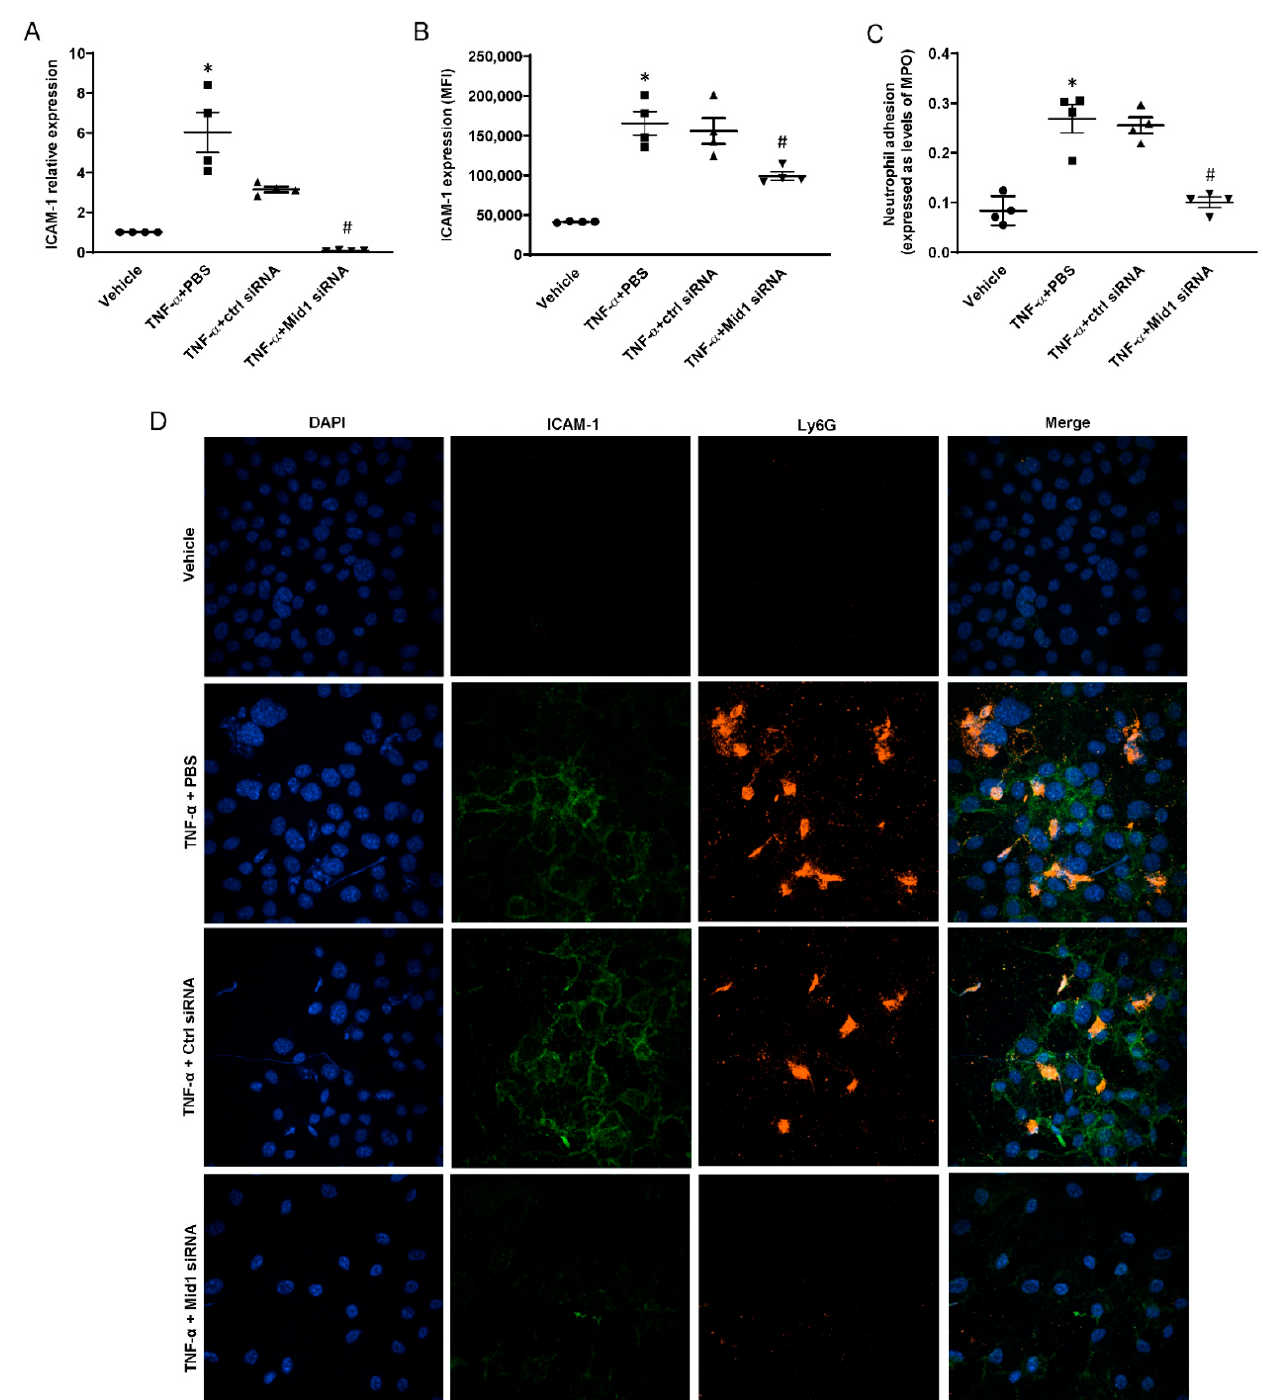
Figure 2. Mid1 siRNA reduced the expression of ICAM-1 and neutrophil adhesion in vitro. eEnd.2 cells were transfected with 100 nM negative control siRNA and Mid1 siRNA for 24 h, then stimulated with 100 ng/mL TNF- α . ( A ) ICAM-1 mRNA expression was determined by RT-qPCR 1 h after stimulation. ( B ) ICAM-1 surface expression was determined by flow cytometry 3 h after stimulation. For the assay of neutrophil adhesion to endothelial cells, eEnd.2 cells were treated as described above, and freshly isolated neutrophils were added to each well for 1 h. ( C ) Neutrophil adhesion was examined in terms of MPO levels, ( D ) ICAM-1 expression and neutrophil adhesion were examined by confocal microscopy. Data are mean ± SEM and n = 4. * p < 0.05 vs. Vehicle, # p < 0.05 vs. TNF- α + Control siRNA.